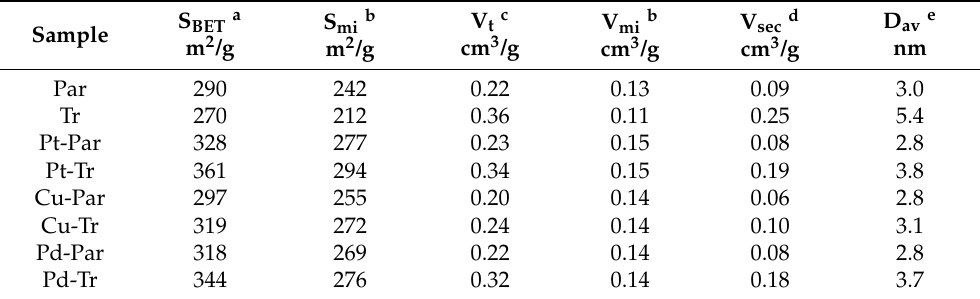
Table 1. Textural properties of samples